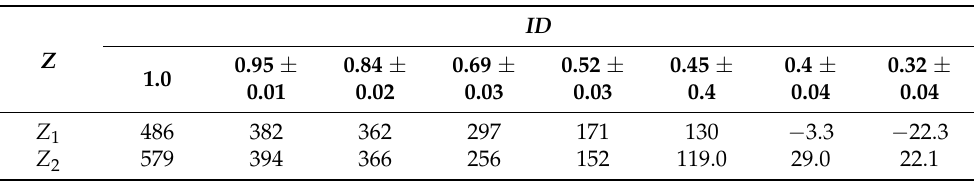
Table 2. Calculation of the statistical significance for multiple alignments of Alu repeats from the human